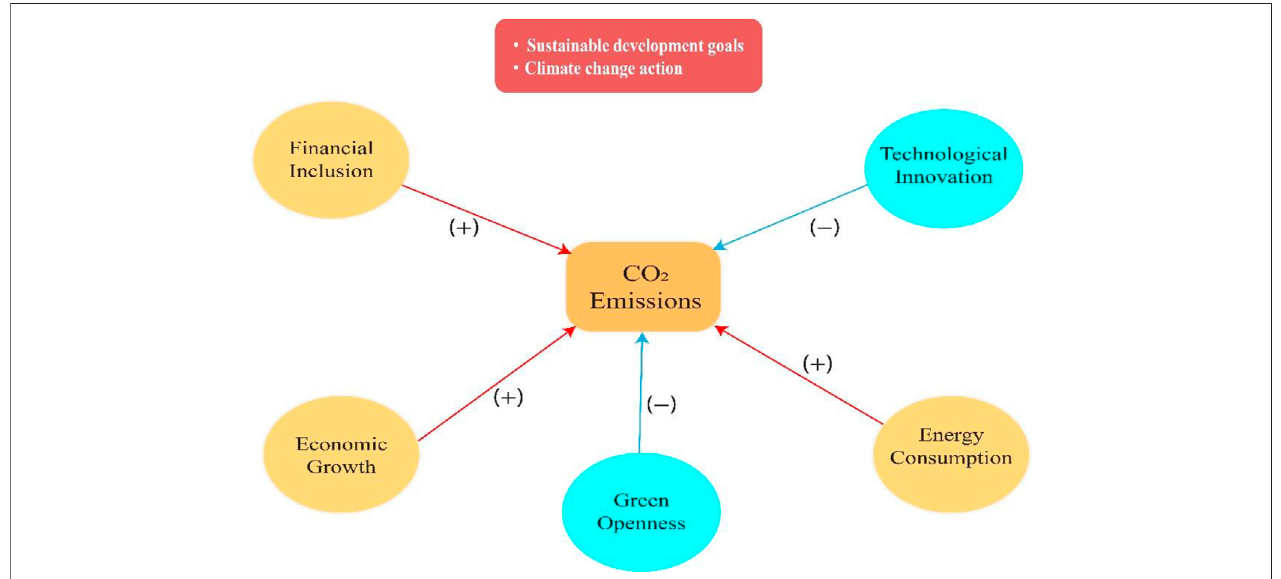
FIGURE 3 | Long-run